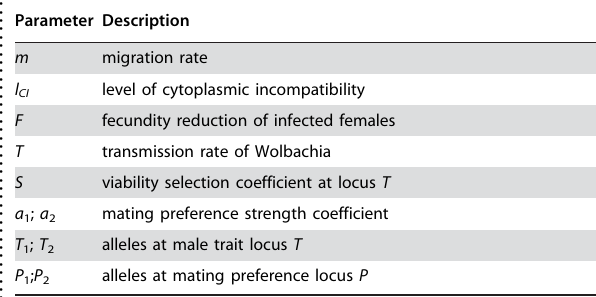
Table 1. Definitions of the parameters and symbols used in